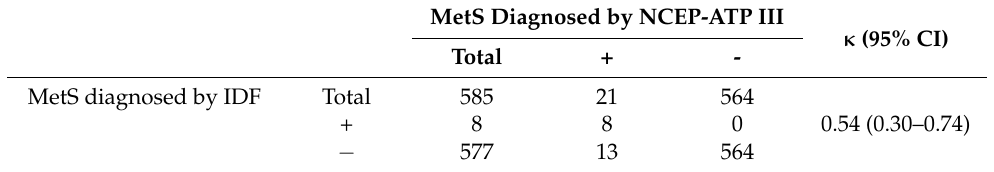
Table 4. Agreement between the NCEP-ATP III and International Diabetes Federation (IDF) criteria in diagnosing MetS.